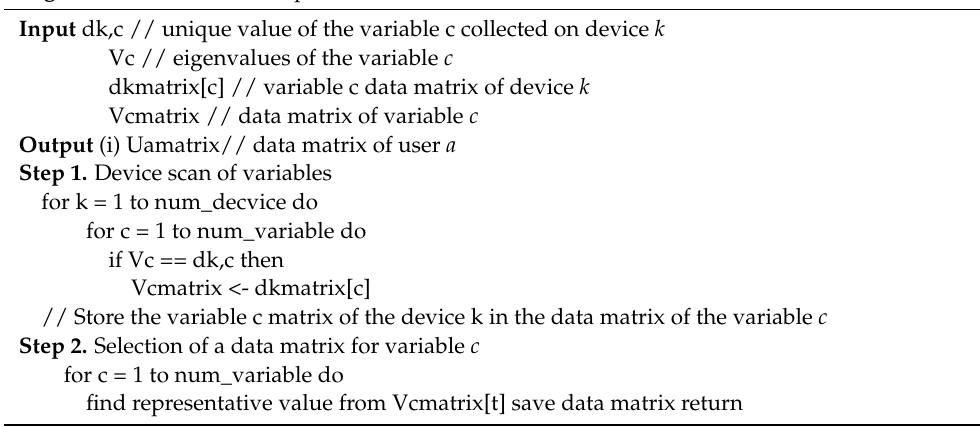
Algorithm 1. Selection of representative